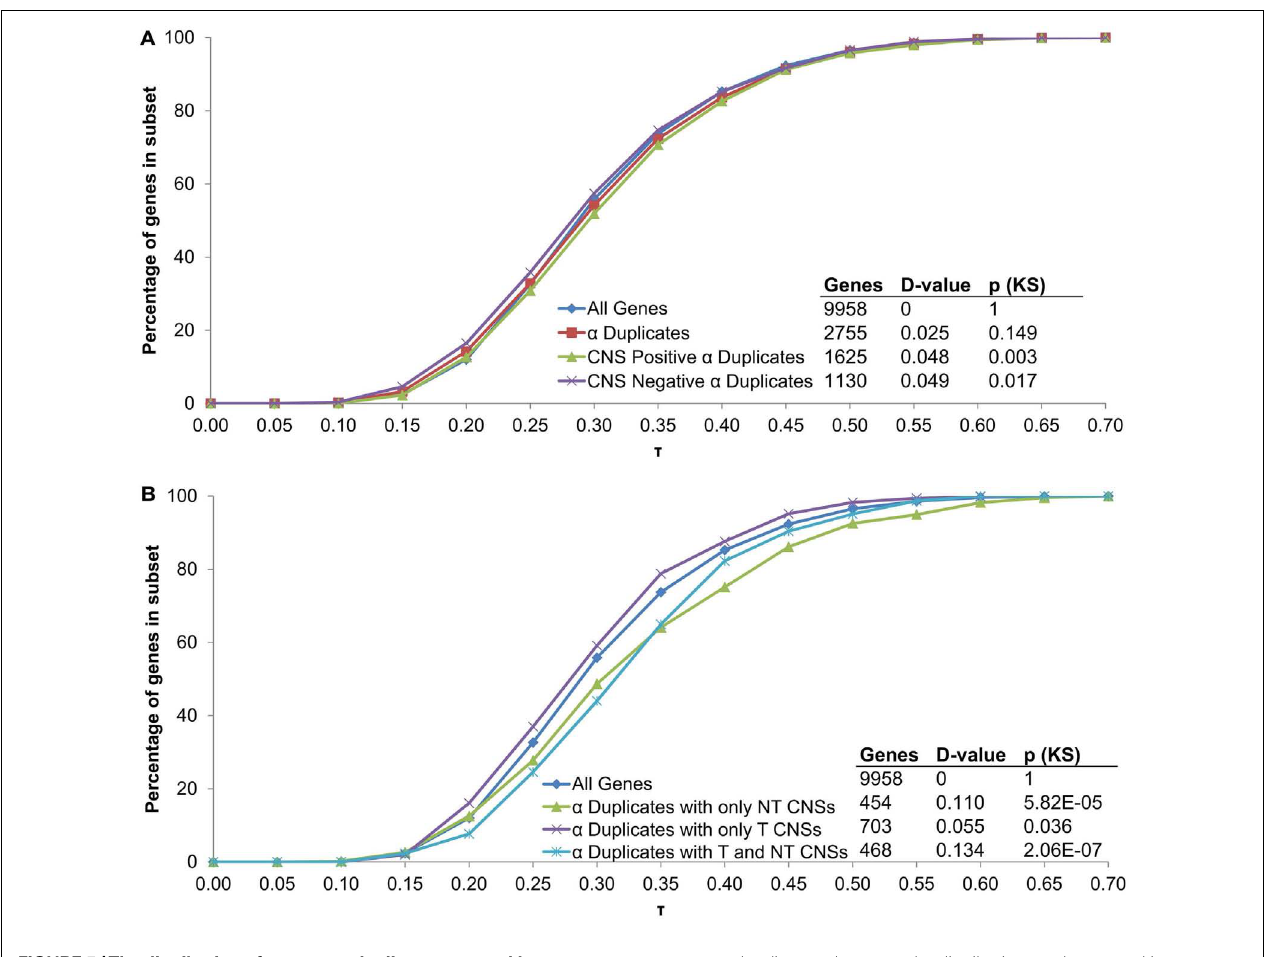
FIGURE 5 |The distribution of τ across α duplicates grouped by (A) CNS presence/absence and (B) subgene position restricted CNS annotation . Each gene subset is restricted to genes with annotated 5 (cid:48) UTR, intron, and 3 (cid:48) UTR sequence.The D -value